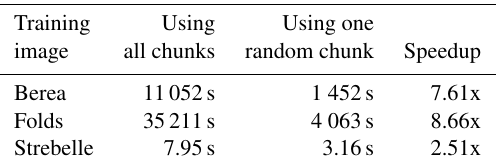
Table A2. Computation times and speedups for the full and partial exploration approaches. Times are specified for simulations with path-level